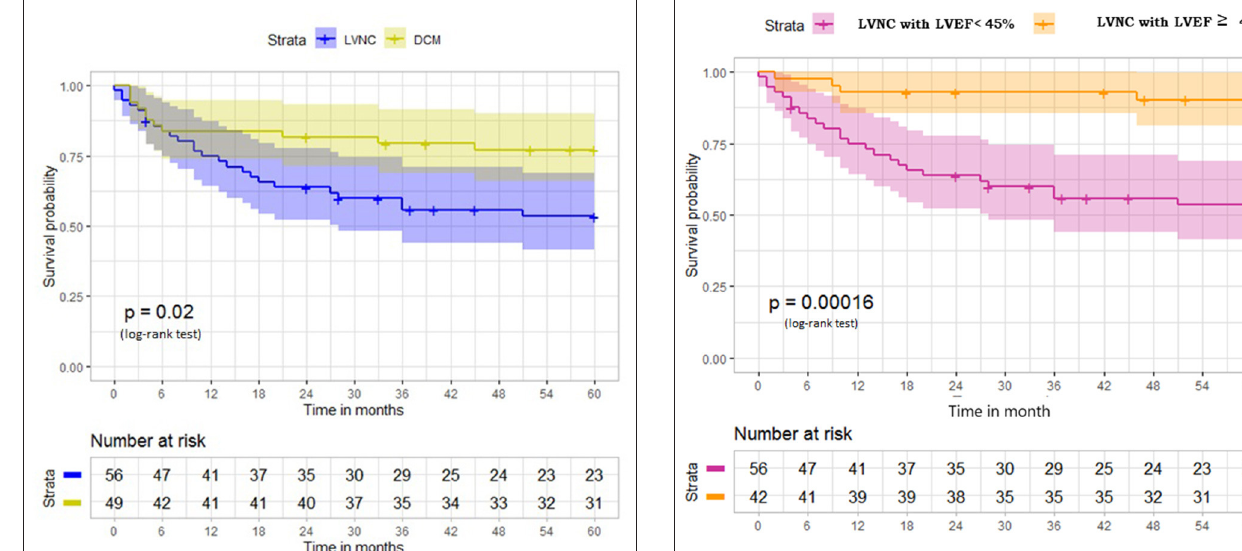
FIGURE 3 | Survival free from primary outcome at 5-year follow-up in patients with left ventricular ejection fraction < 45%. LVNC, left ventricular non-compaction; DCM, dilated cardiomyopathy.